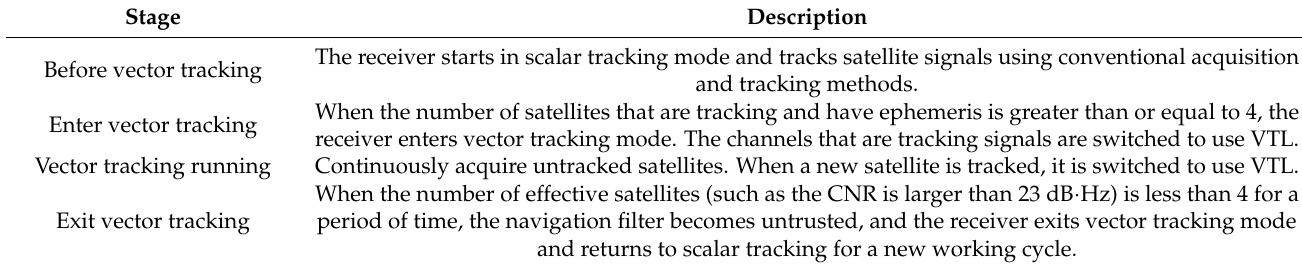
Table 2. Workflow of vector receiver.